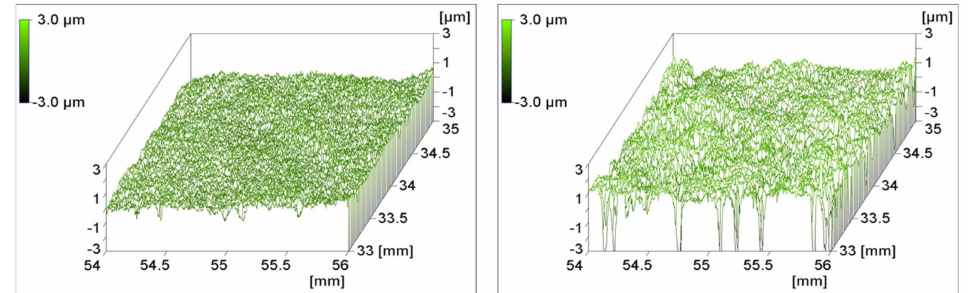
Figure 5. Surface roughness of a PEEK film dipped into chromium sulfuric acid for 5 s ( left ) and 60 s ( right ).